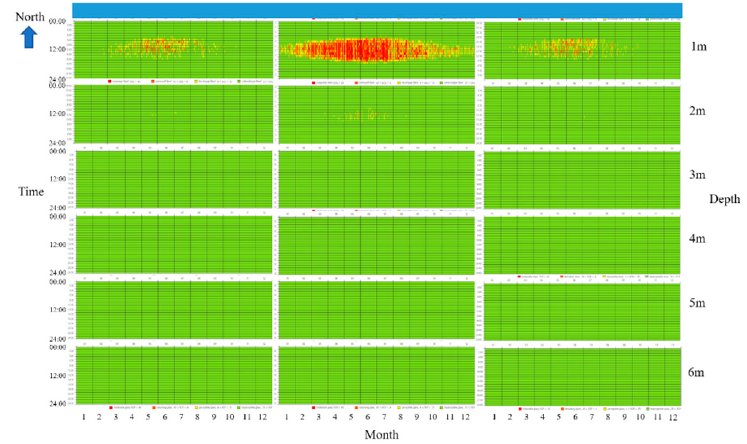
Figure 10. Annual glare level at each depth of the north-facing room.